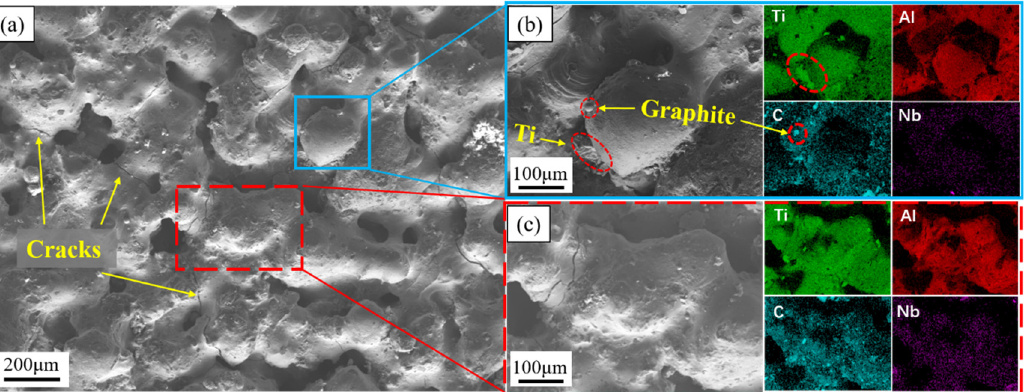
Figure 12. ISLF sample surface of 40 W 100 mm/s: ( a ) SEM image, ( b ) partially enlarged image and EDS image, ( c ) partially enlarged image and EDS image.